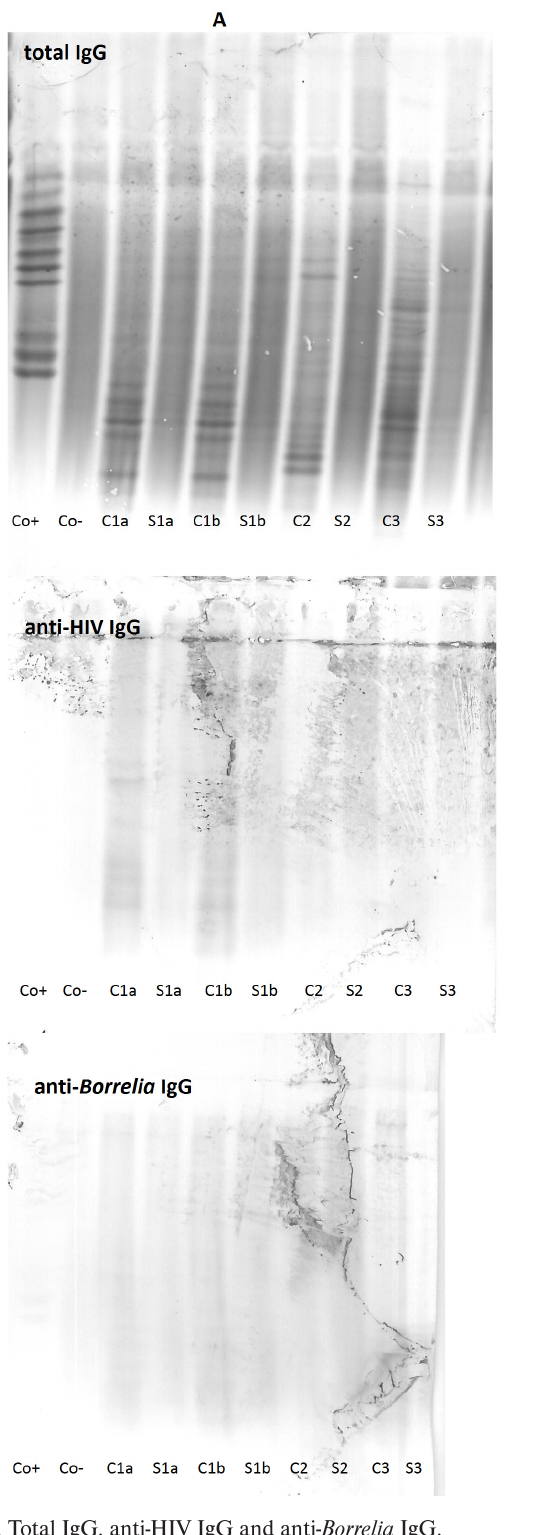
Fig. 1. Total IgG, anti-HIV IgG and anti- Borrelia IgG. Panel A (left): chromogenic detection. 6 ng of IgG were applied for analysis of total o-IgG and 30 ng of IgG for the analysis of antigen-specific o-IgG. Panel B (right): chemiluminescent detection. 1.5 ng of IgG were applied for analysis of total IgG and 15 ng of IgG for the analysis of antigen-specific o-IgG. Exposition times were 7 s for total IgG and 63 s for antigen-specific IgG. o-IgG reactivity against HIV, but not against Borrelia purified protein, can be observed in C1a (unfrozen CSF stored at +4°C for 45 days) and C1b (CSF stored frozen at -30°C). No reactivity of o-IgG against HIV in o-IgG positive samples of the other two patients (C2, S2 and C3, S3) can be seen. Co+, positive CSF control for o-IgG test (Sebia); Co-, negative control (purified intravenous IgG preparation); C, cerebrospinal fluid; S,